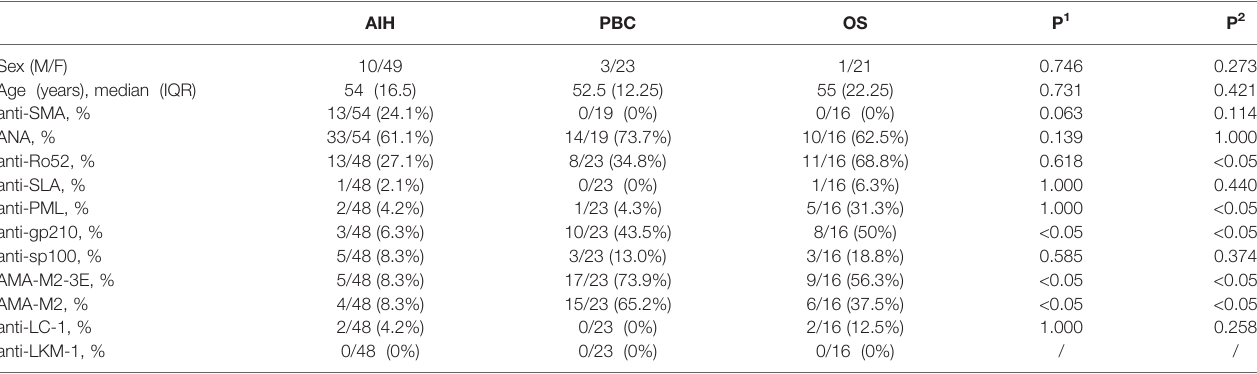
TABLE 1 | Autoantibody characteristics of AIH patients, PBC patients and OS